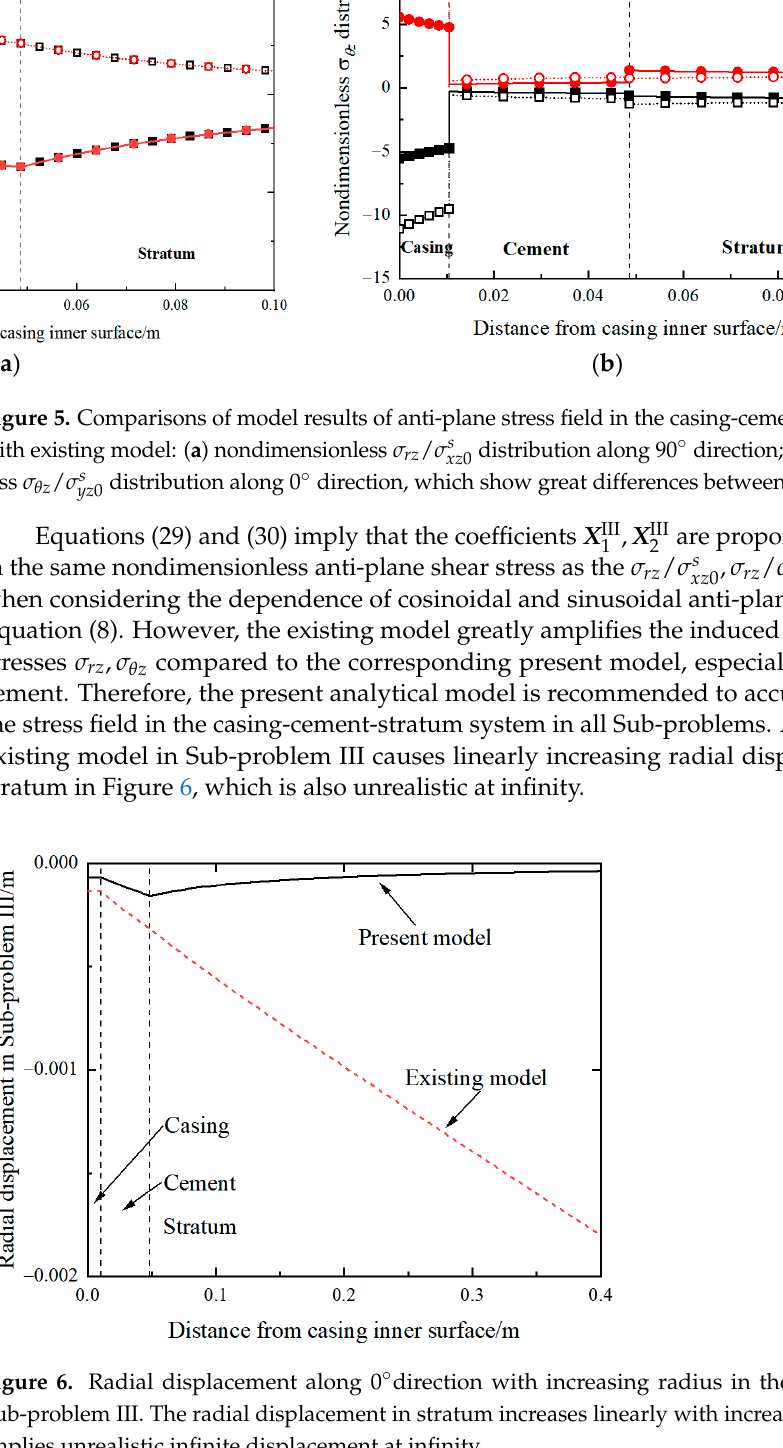
Figure 5. Comparisons of model results of anti-plane stress fi eld in the casing-cement-stratum sys-